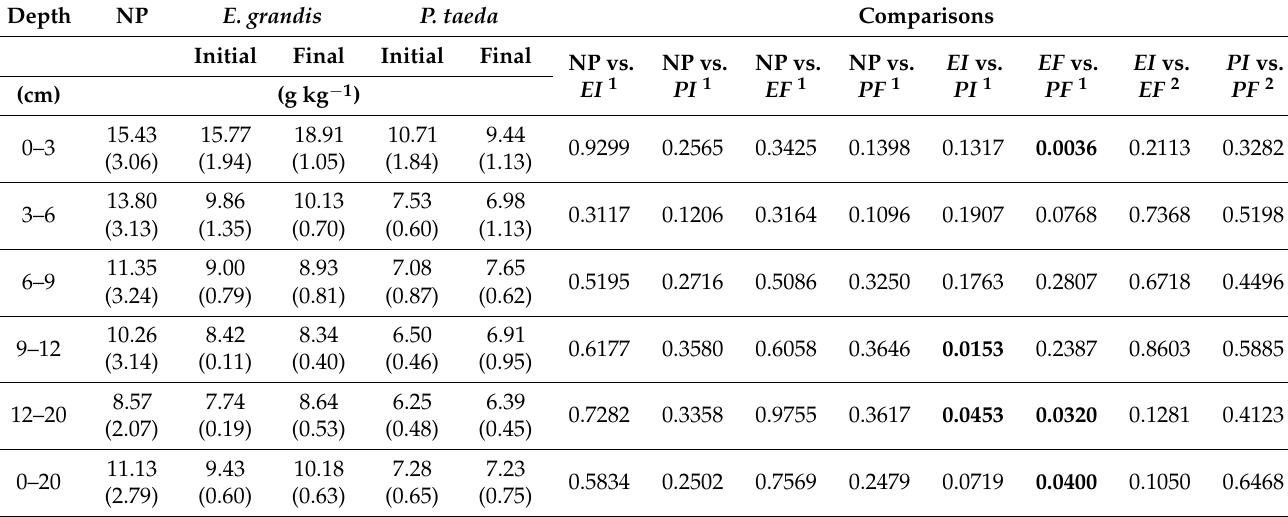
Table 8. Soil organic C concentration under P. taeda , E. grandis and native pastures at the beginning and end of the study. Depth